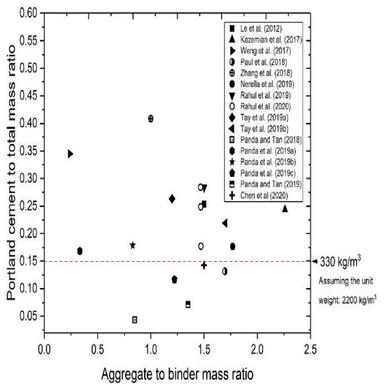
Literature survey of OPC content and aggregate to binder mass ratio in different 3D printable mortars. Data from Refs:,,43–.